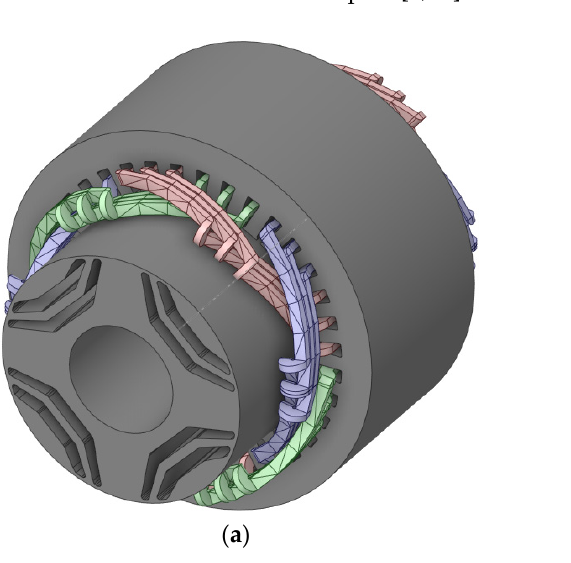
Table 1. Main data of the selected